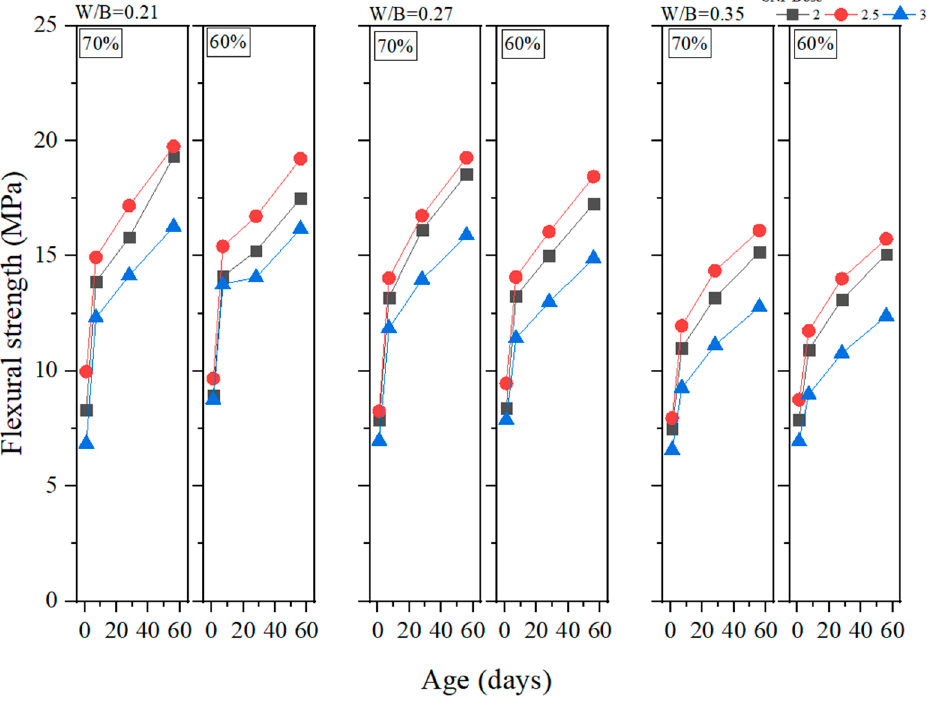
Figure 13. Flexural strength of green and ecofriendly grouting material with SNF.